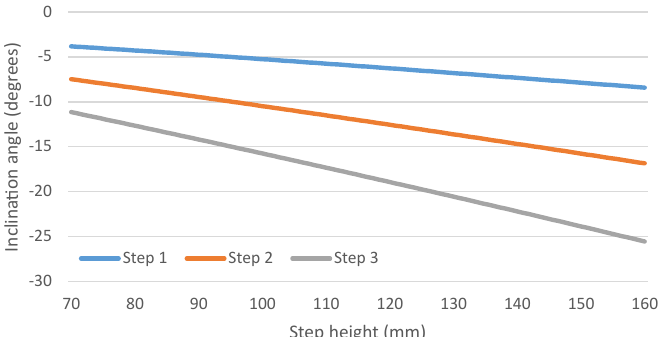
Figure 13. Variation of inclination angle of the robot with change in height of step during the act of climbing down the stairs.